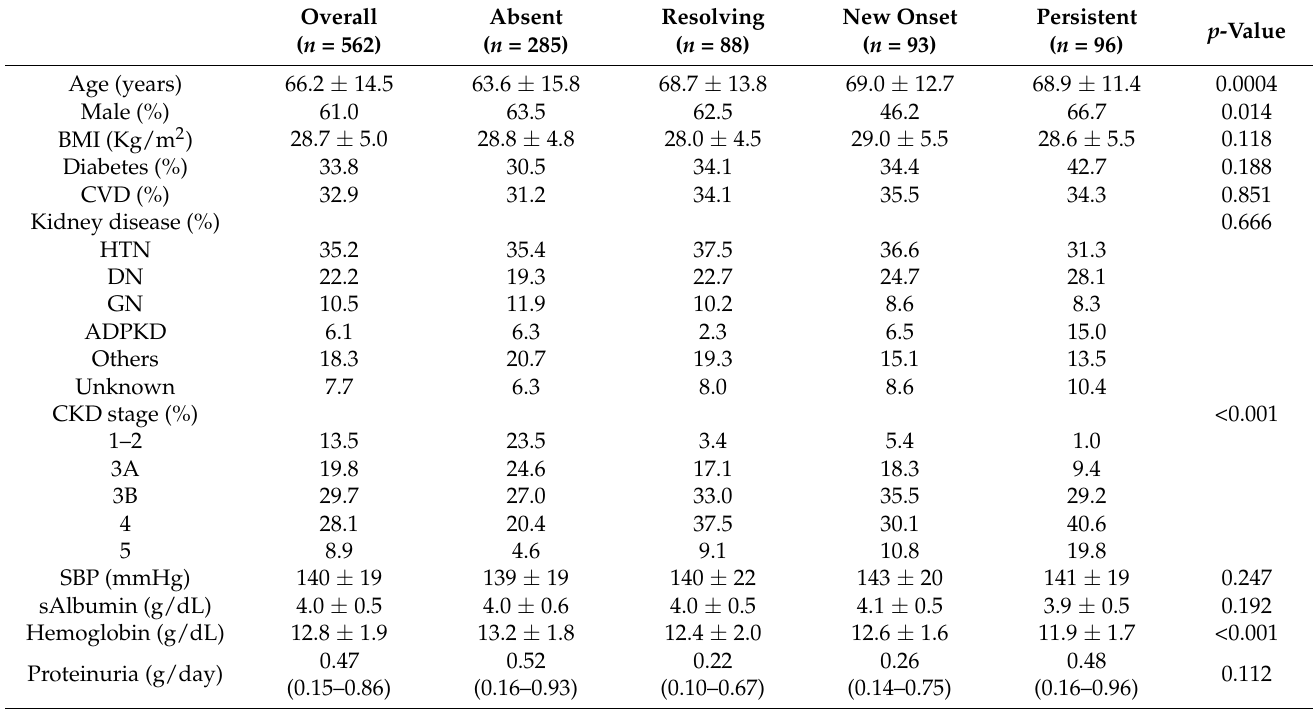
Table 1. Main clinical features of patients at baseline, overall and by HK